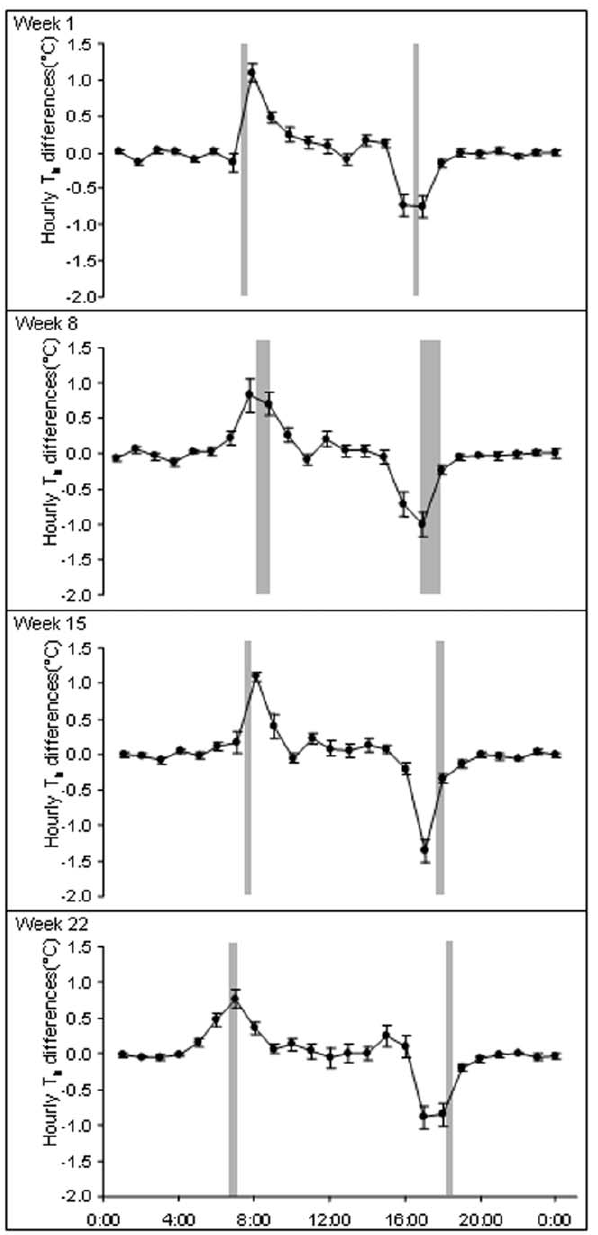
Figure 5. Mean ± SE T b changes between successive hours across all eight individuals during the first, eighth, fifteenth and twenty-second weeks of the measurement period. Grey bars represent the mean 6 SE times of emergence (left-hand bar) and immergence (right-hand bar).